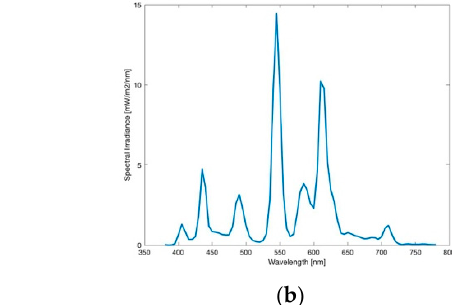
Figure 11. ( a ) Image of the ring-shaped light during daytime; ( b ) Spectrum of lamp observed.